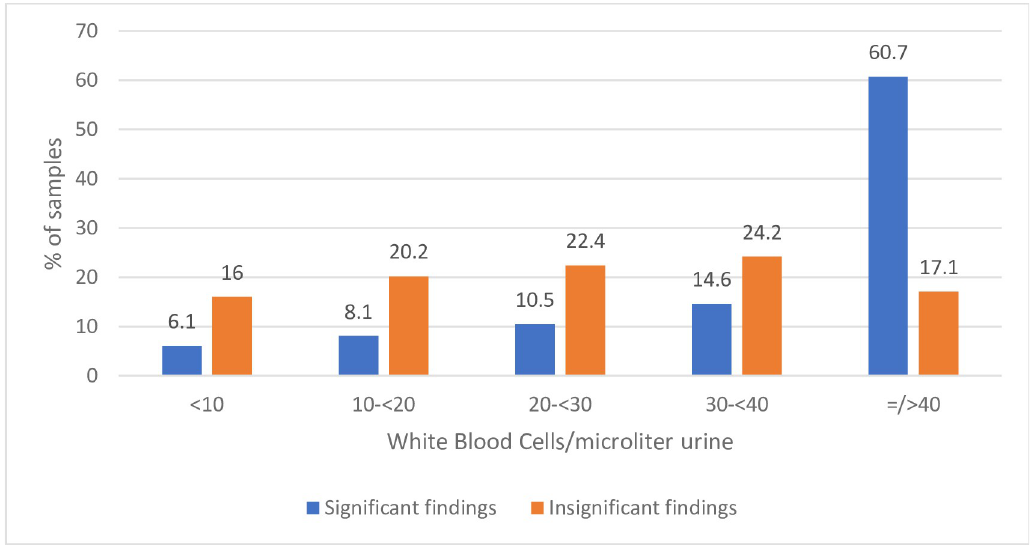
Fig 2. Flowcytometric findings (WBCs/ μ l) in culture plated samples with significant growth (significant findings) and non- significant growth (non-significant